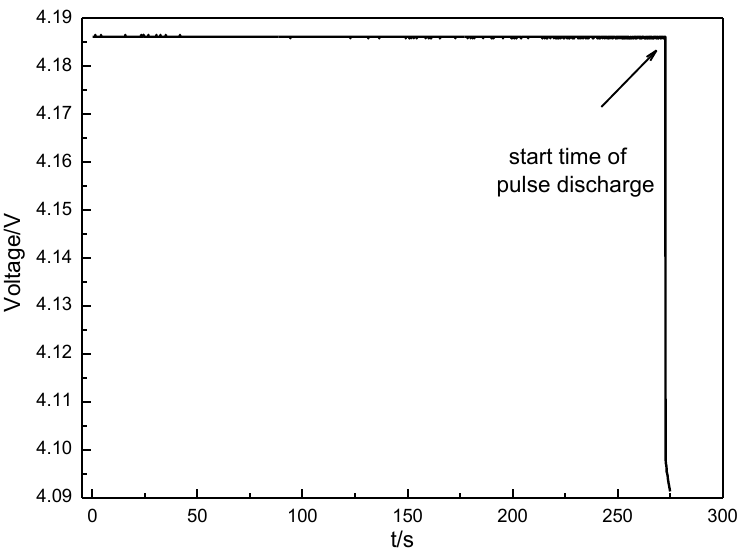
Figure 8. Voltage curves of the discharge and relaxation periods of 2-RC circuit model at SOC = 0.4: ( a ) ∆ t = 0.1 s; ( b ) ∆ t = 0.2 s; ( c ) ∆ t = 0.5 s; ( d ) ∆ t = 1.0 s.